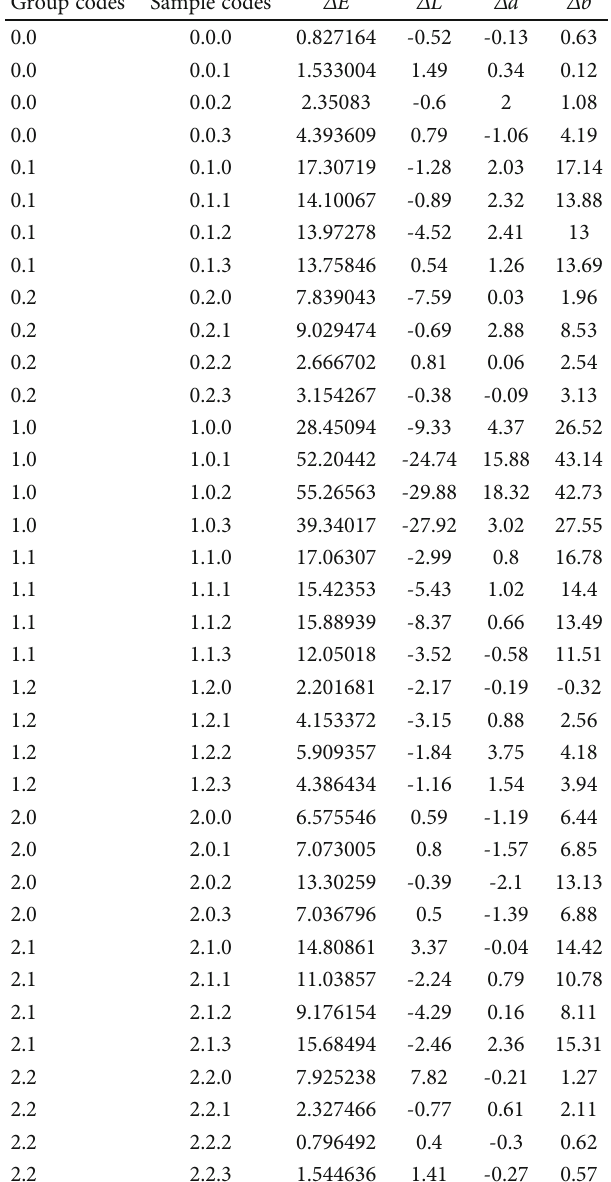
Table 1: Variations in color coordinates of samples after